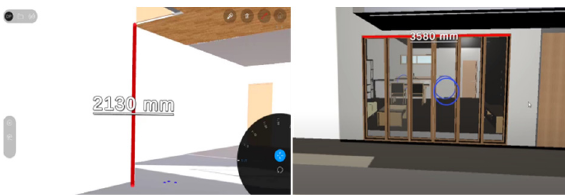
Figure 12. Implementation of measurement function.